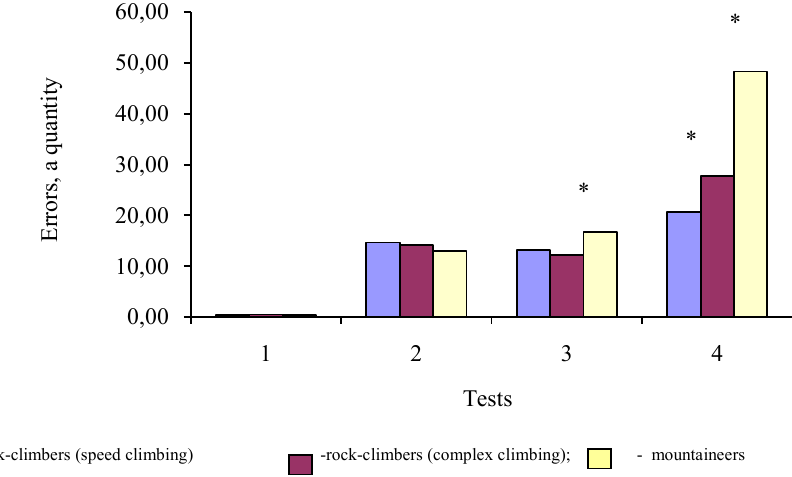
Fig.4. Quantity of errors in fulfillment of tests for determination of latent response time of elite athletes, specializing in speed climbing (n=10),climbing on complexity (n=10) and mountaineers